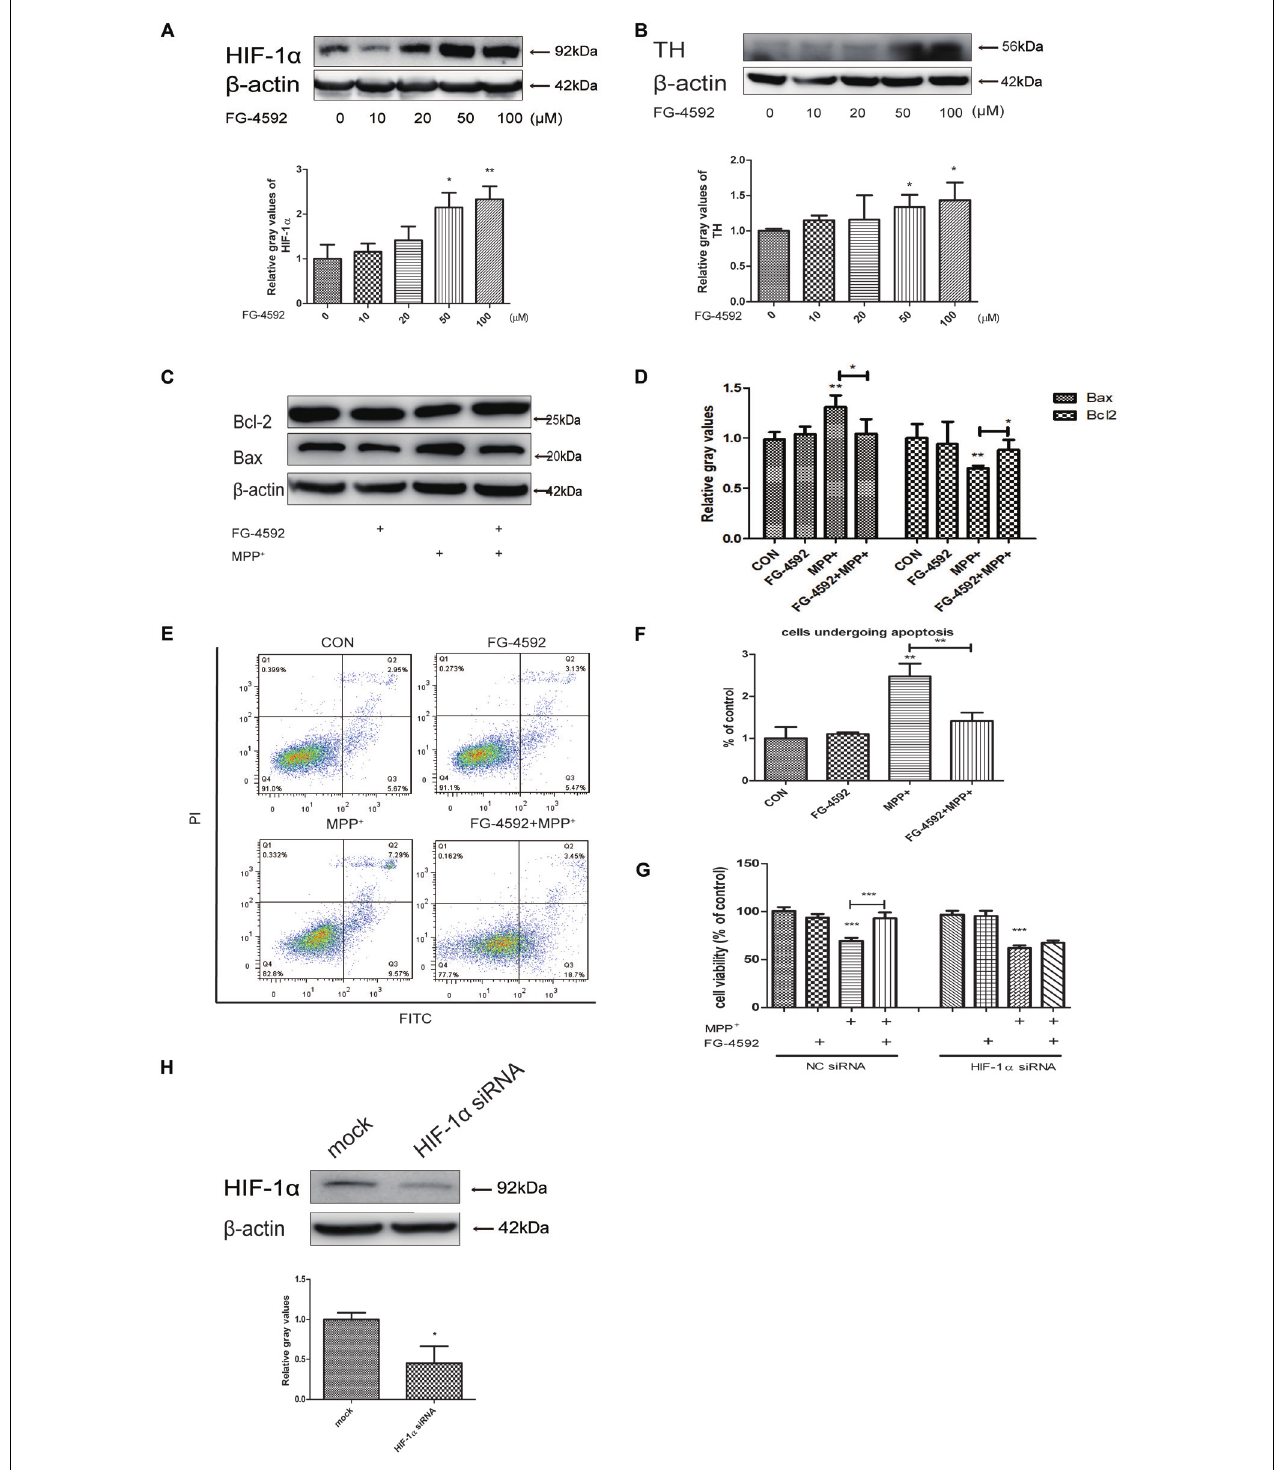
FIGURE 2 | FG-4592 increased the expression of HIF-1 α and attenuated MPP + -induced cell damage in SH-SY5Y cells. (A) SH-SY5Y cells were treated with FG-4592 at various concentrations for 24 h. (B) Cells were treated with FG-4592 at 50 µ M for different time durations. SH-SY5Y cells were exposed to MPP + (3.5 mM) in the presence or absence of FG-4592 for 24 h, apoptosis of cells was determined by immunoblotting assay (C,D) and Annexin V-FITC assay (E,F) , Cell viability was determined by CCK8 assay (G) . (H) Represented the protein level in SH-SY5Y cells after transfected with siRNA of HIF-1 α . The quantification of HIF-1 α protein was as below. Data were expressed as means ± SD, ∗ P < 0.05, ∗∗ P < 0.01, ∗∗∗ P < 0.001 as compared to the control or MPP + ( n ≥ 3).